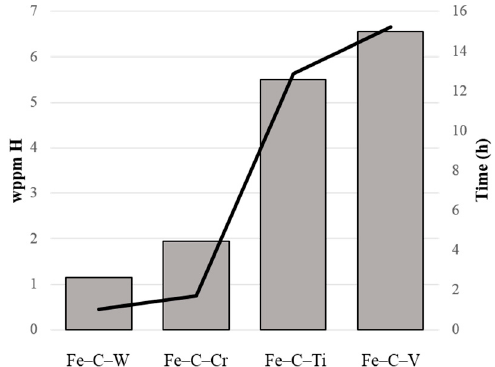
Figure 5. H diff obtained by hot extraction in wppm (grey bars) and the time (h) from hydrogen breakthrough till the steady state condition is reached (black line).